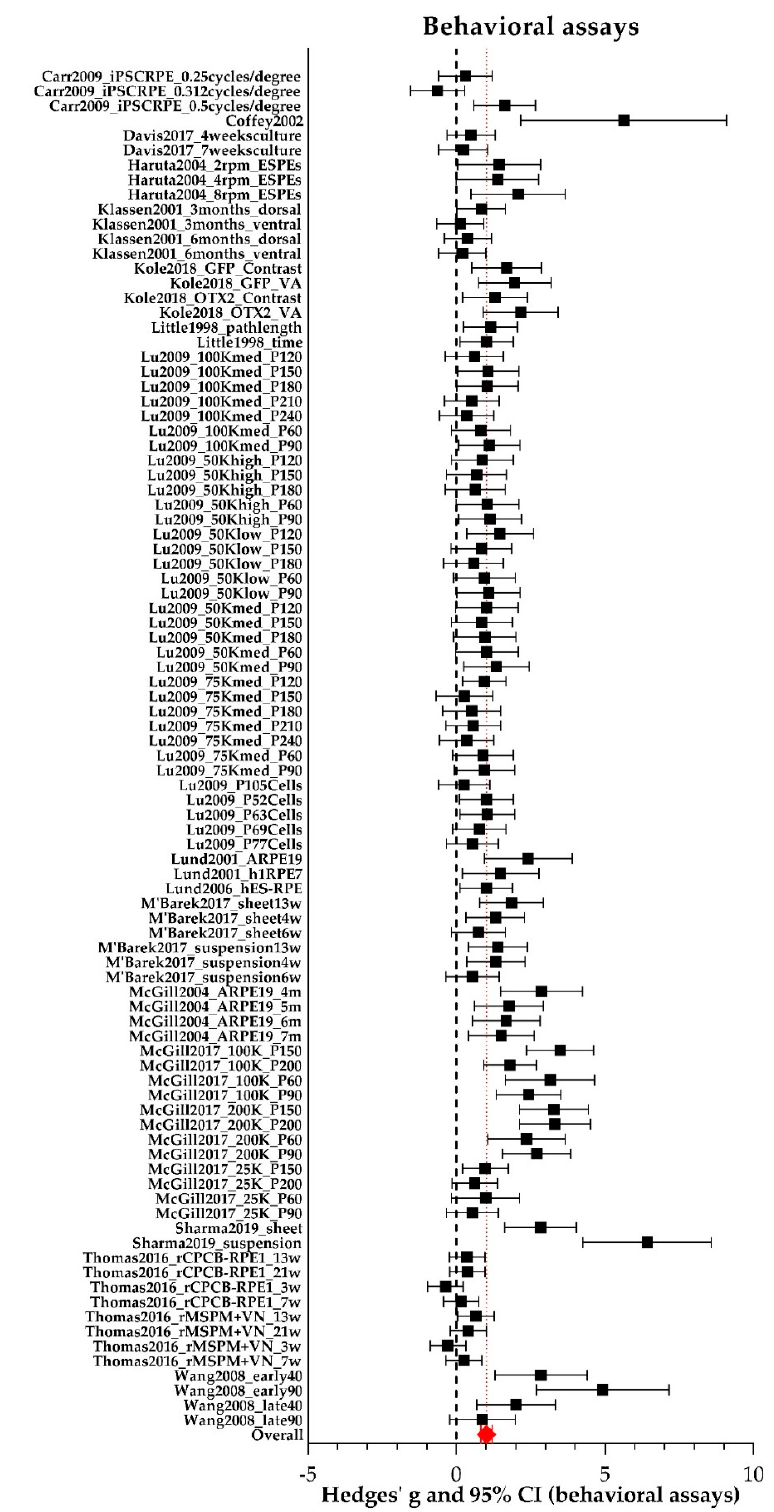
Figure 8. The meta-analysis on the effect of RPE transplantation on the outcome of vision-based behavioral assays. For every experimental group, Hedges’ g (a measure for effect size using smaller sample sizes, black solid squares) and its 95% confidence interval (CI) are graphically shown. The left side of the dashed black line (Hedges’ g = 0) favors the control group (untreated or sham-operated) and the right side favors the experimental group (RPE transplantation). Overall, RPE transplantation increased vision-based behavior (Hedges’ g 1.018 (0.826–1.209), red diamond).